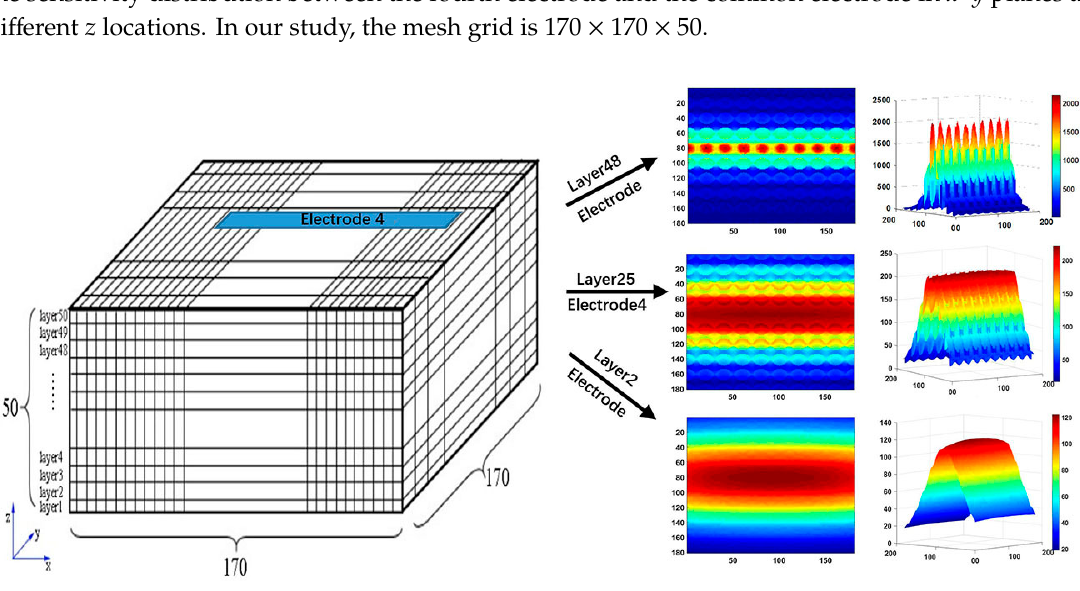
Figure 4. Sensitivity distribution at different z directional layers while capacitance array is placed horizontally.